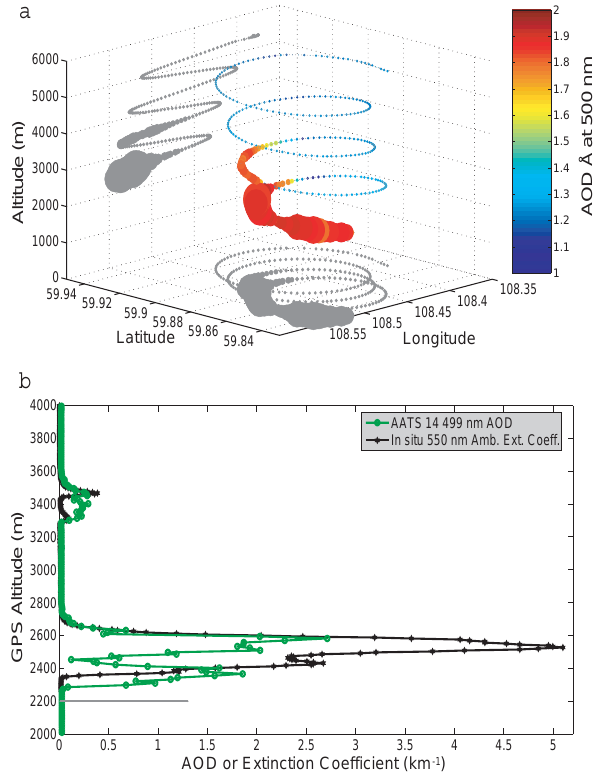
Fig. 4. (a) The spiral flown on 10 July, 21:27–21:37, north of Lake Athabasca. Marker size is proportional to the AOD at 499.4nm, which went up to 2.7. The same flight track is projected on two planes in grey. The smoke plume was located on the western edge of the ∼ 6-km-wide spiral up to ∼ 3500m. (b) AATS-14 AOD at 499.4nm (green) and in situ (neph+PSAP) extinction coefficient at 550nm in km − 1 between 2000–4000m (GPS altitude) of the verti- cal profile. The grey horizontal bar indicates the variability measure used in Fig.